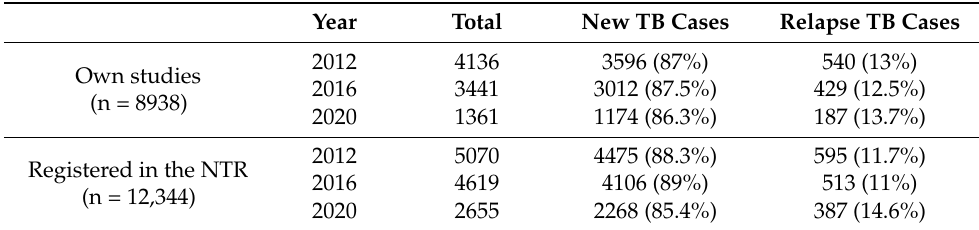
Table 3. Comparison of data on new cases and relapse tuberculosis cases between the authors’ studies and data from the National Tuberculosis Registry (NTR) in Poland in 2012, 2016, and